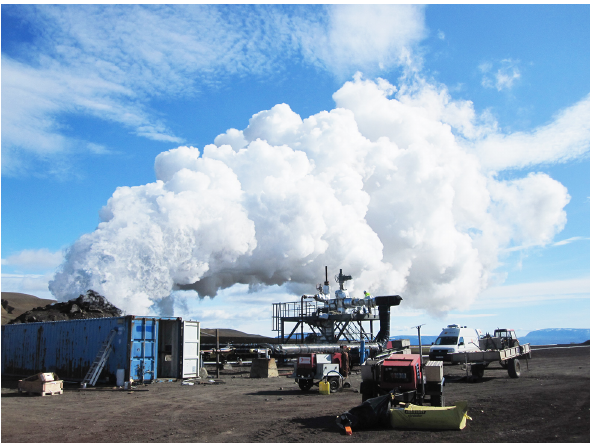
Figure 2. The availability diagram for pure water, i.e., its power- producing potential at specified specific-state conditions of temper- ature and pressure (Tester, 2006, Fig. 1.10).